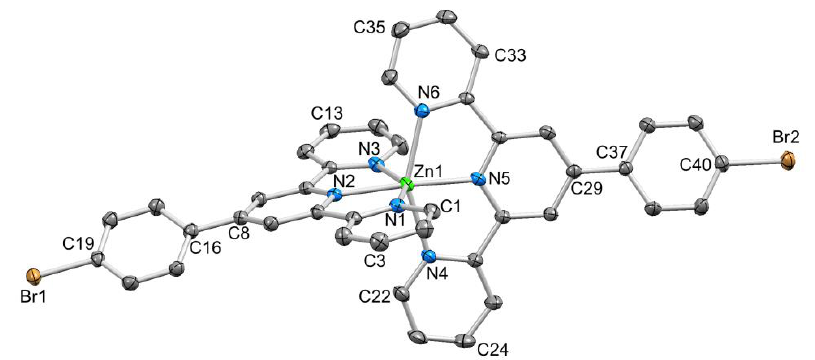
Figure 3. ORTEP-style depiction of the [Zn( 1 ) 2 ] 2+ cation. Hydrogen atoms omitted and ellipsoids plotted at 50% probability level. Selected bond parameters: Zn1–N1 = 2.179(2), Zn1–N2 = 2.087(2), Zn1–N3 = 2.198(2), Zn1–N4 = 2.212(2), Zn1–N5 = 2.079(2), Zn1–N6 = 2.169(2), C19–Br1 = 1.896(3),